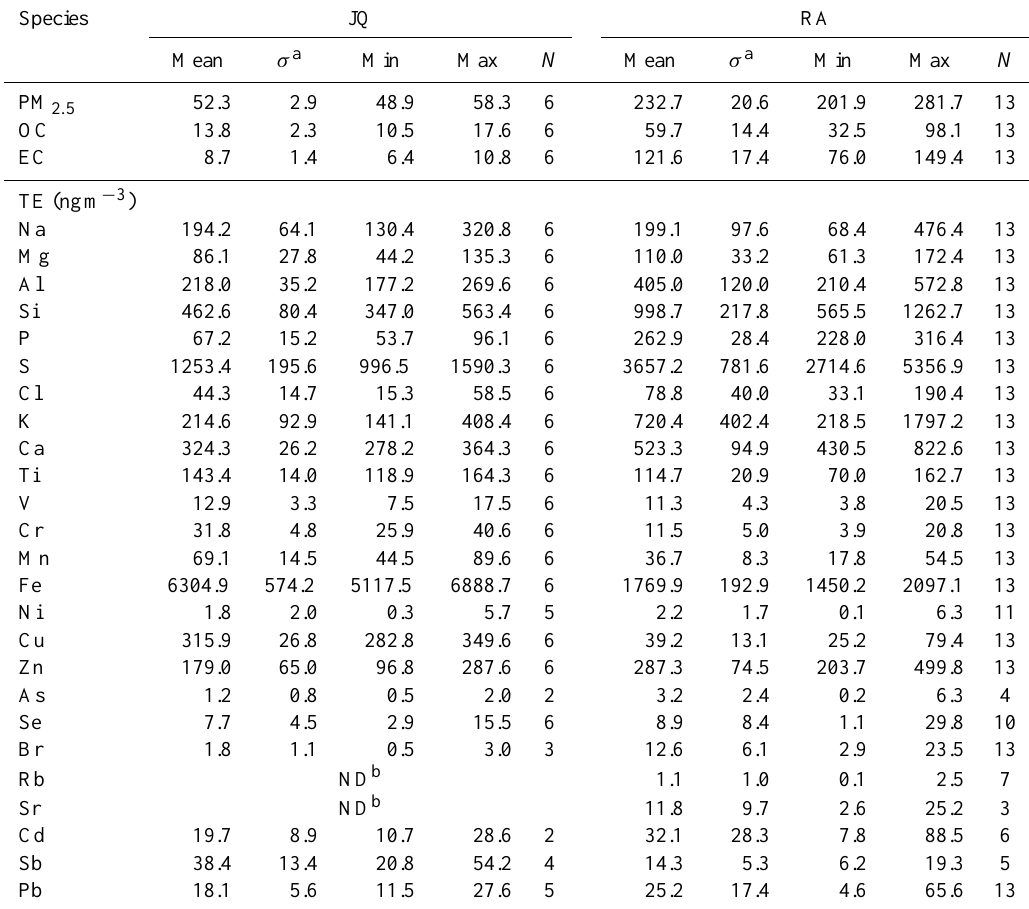
Table 2. Species concentrations in the studied tunnels. PM 2 . 5 , OC, and EC are given in µgm − 3 . Trace elements are given in ngm − 3 . N indicates the number of collected filters where a given parameter has been